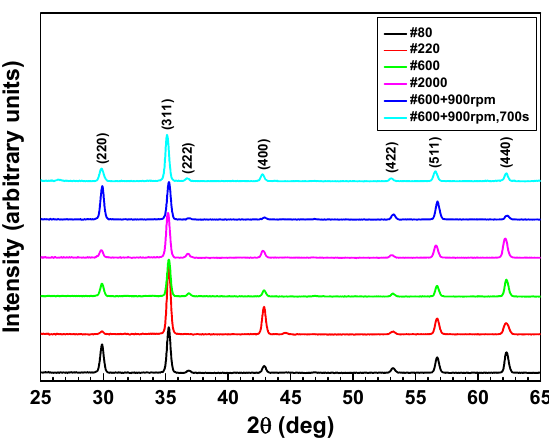
Figure 8. X-ray diffraction (XRD) patterns of the magnetite film on carbon steel substrates with different roughnesses and agitation speeds at − 1.05 V SCE in Fe(III)–TEA solution at 80 °C.